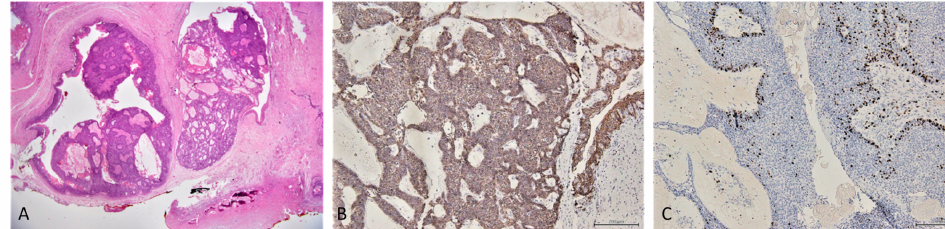
Figure 7. An H and E-stained section ( A —magnification × 12.5) and immunohistochemical stain- ing of a case of solid/multicystic/conventional ameloblastoma, showing expression of E-cadherin ( B —magnification × 100) and Ki67 ( C —magnification ×